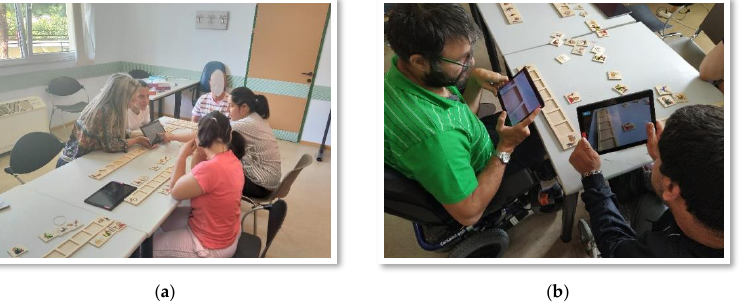
Figure 34. Team evaluation: ( a ) students with intellectual disability; ( b ) students with cerebral palsy and without intellectual disability.